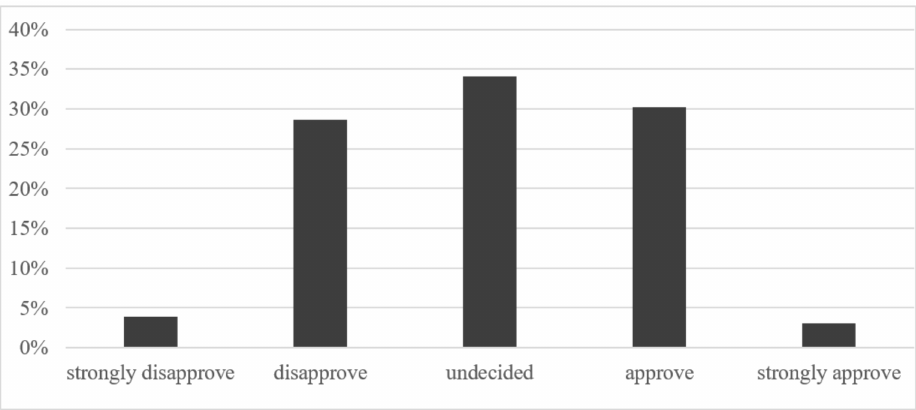
Figure 11. Green investments will change the bank’s capital structure (in percent). Source: own work.